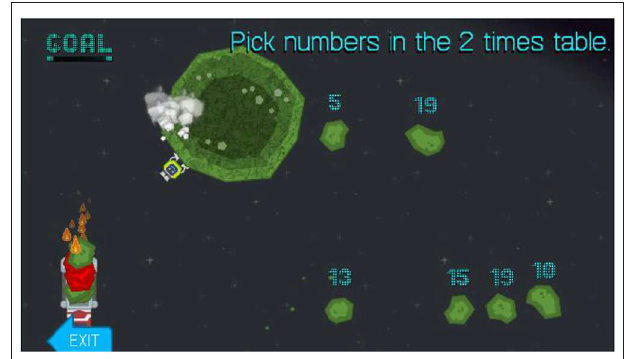
FIGURE 1 | Screenshot from RAIDING game, 2-times-table